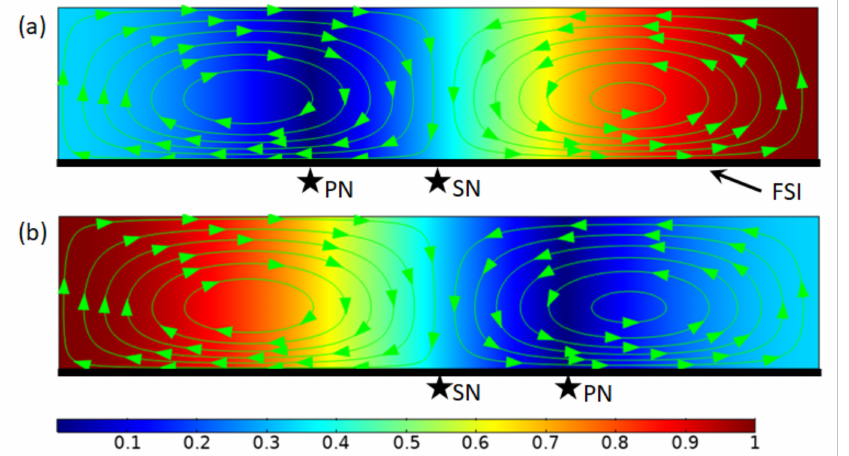
Figure 2. Outer acoustic streaming due to one-dimensional asymmetric acoustic resonances over a fluid-solid interface (FSI). ( a ) S 0 = A 0 /2; and ( b ) S 0 = − A 0 /2. The background colors plot normalized acoustic pressure magnitudes and the streamlines show outer acoustic streaming in a confined fluid driven by the limiting velocities over the FSI. PN and SN denote locations of acoustic pressure node and acoustic streaming node, respectively.